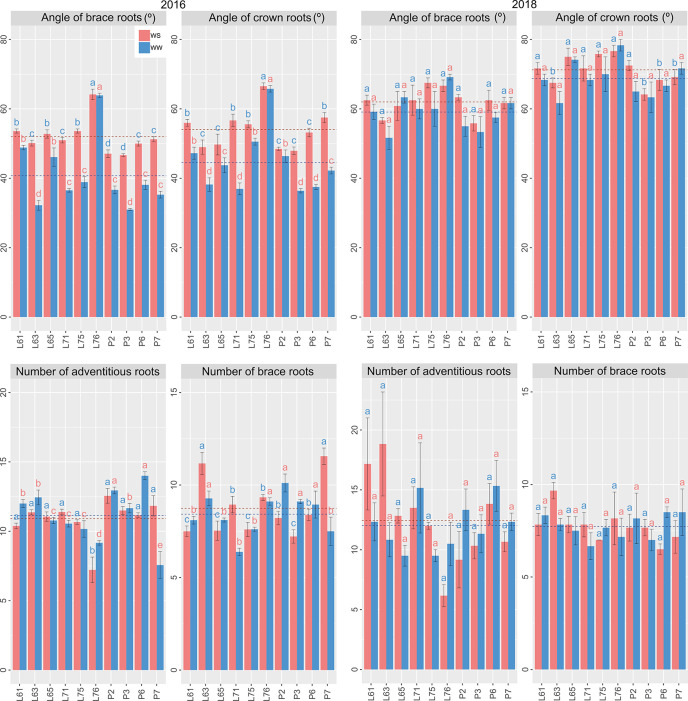
Root traits of popcorn inbred lines under WS and WW conditions in CS 2016 and 2018. Mean genotypes, red (WS) and blue (WW), followed by the same letter do not differ using the Scott and Knott test at 5%. The bars denote the standard error.